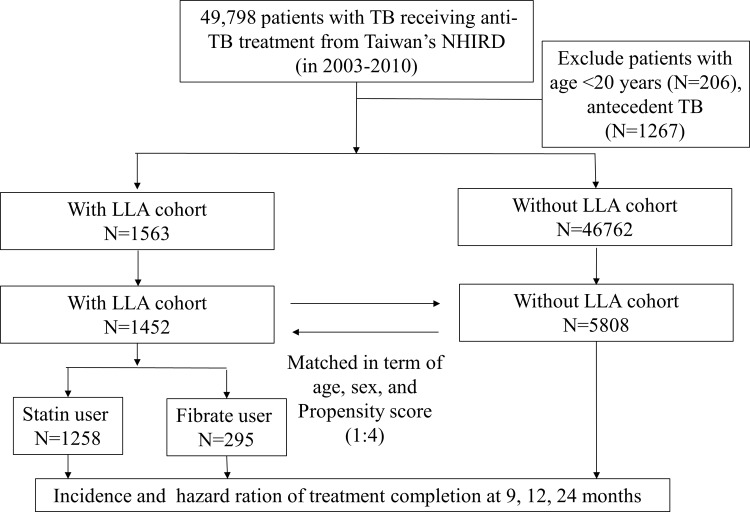
Overall framework of the research design and sampling strategy.NHIRD: National Health Insurance Research Database; TB:tuberculosis; LLA: lipid lowing agent.